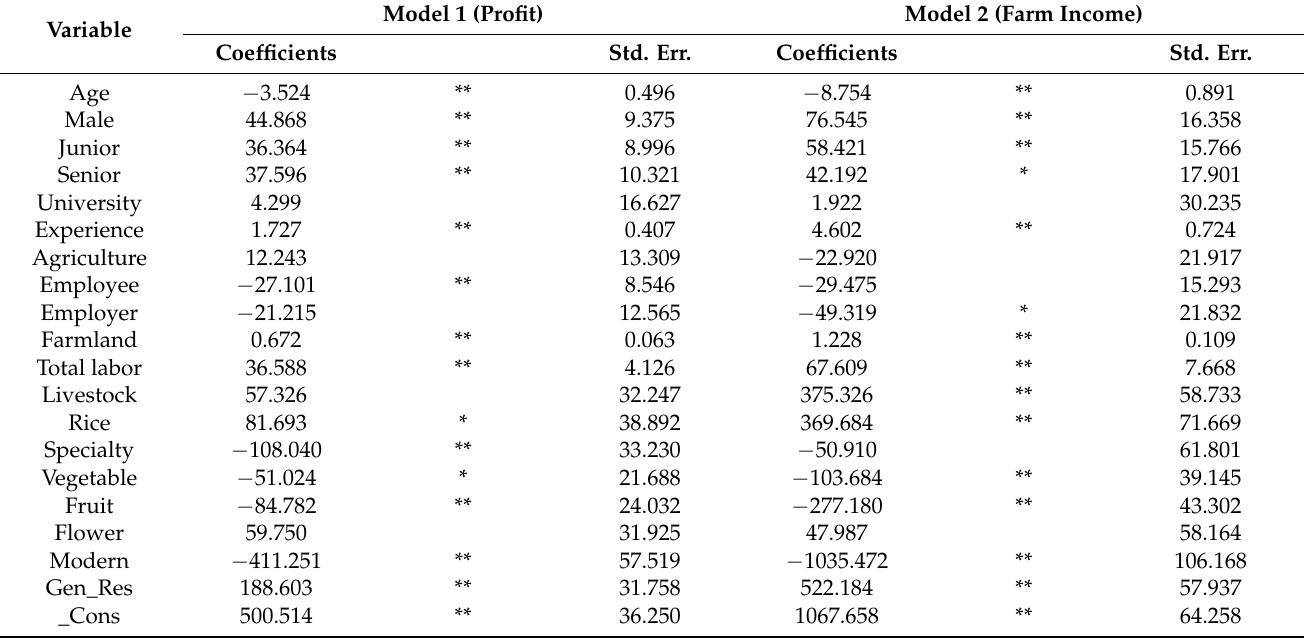
Table 3. Two-step control function